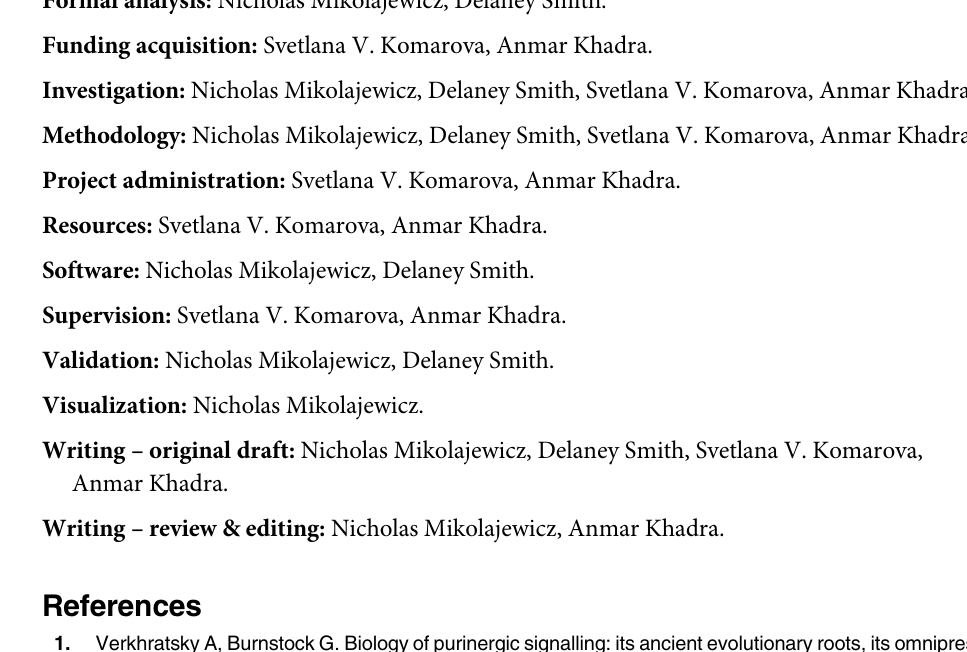
three independent murine cell lines ( A , left panel; B ) were aligned using a linear transforma- tion to match peaks/troughs ( A , middle panel; C ) and responses were rescaled to [0,1] interval ( A , right panel; Fig 1C ). Curves : Loess curves; Markers : Response means ( circle : BM-OB; trian- gle : C2-OB; square : CB-OB). S1 Table. Calcium response parameters. S2 Table. Primer and PAM sequences. S3 Table. PCR cycling